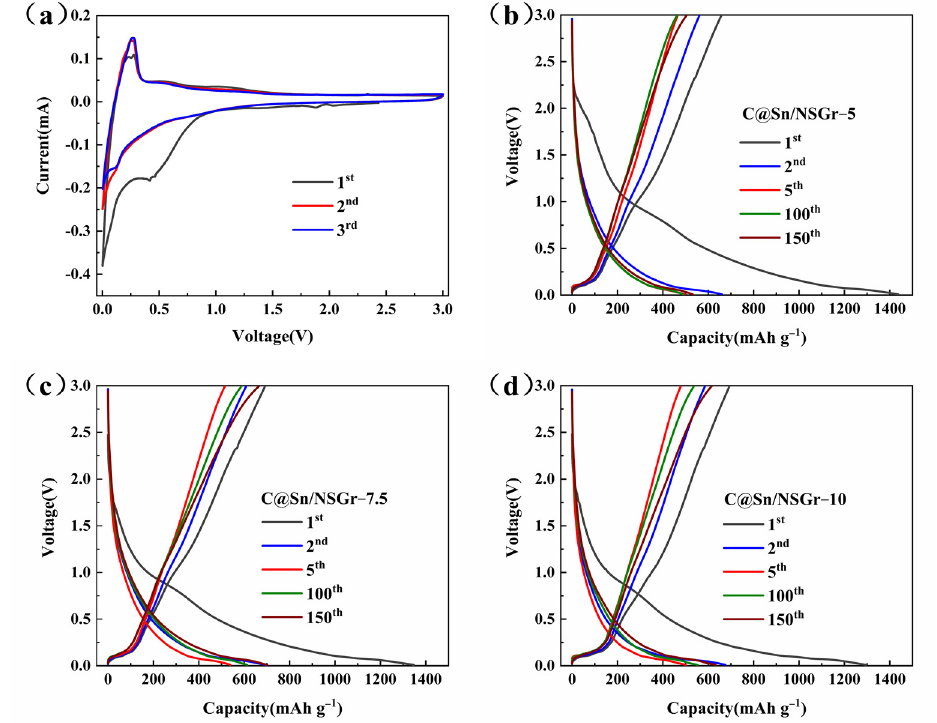
Figure 5. CV curves of C@Sn/NSGr − 7.5 ( a ) at a sweep rate of 0.1 mV s − 1 ranging from 0.01 V to 3.00 V, charge–discharge curves of C@Sn/NSGr − 5 ( b ), C@Sn/NSGr − 7.5 ( c ) and C@Sn/NSGr − 10 ( d ).